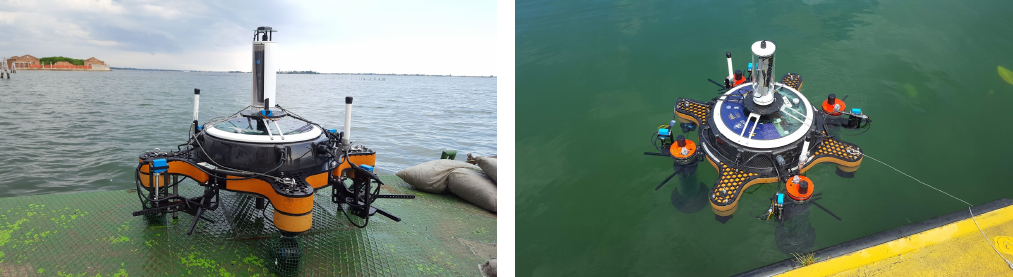
Figure 1. Final version of the aPad platform ready for deployment on-site ( left ) and an aPad fully loaded with four docked aMussels ( right ).